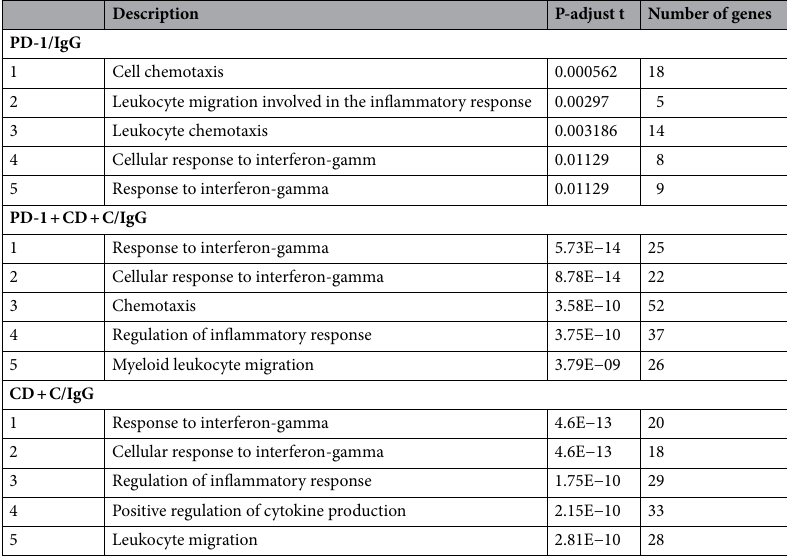
Table 2. Top 5 significantly enriched GO terms. The differentially expressed genes are summarized in the immune response. Gene Ontology enrichment analysis of biological processes for upregulated and downregulated genes between IgG vs anti-PD-1, vs anti-PD-1 + chidamide + celecoxib, and vs chidamide + celecoxib treated tumor samples were